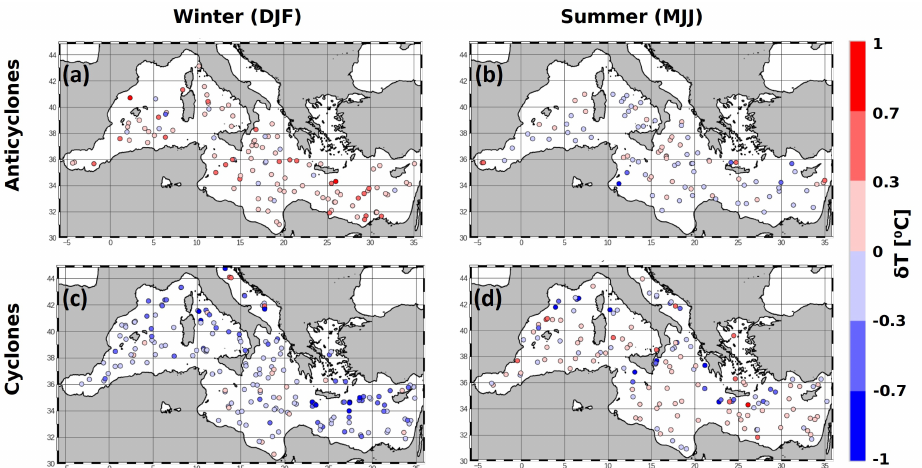
Figure 7. Spatial variation of δ T values in the Mediterranean Sea for ( a ) Anticyclones in winter, ( b ) Anticyclones in summer, ( c ) Cyclones in winter, and ( d ) Cyclones in summer. Red (Blue) dots correspond to warm (cold) anomalies. The colour intensity depicts the absolute value of the